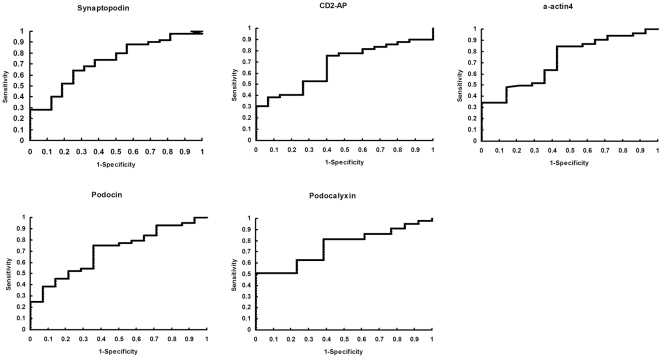
ROC-curve analysis of mRNA levels.Fraction of true positive results (sensitivity) and false positive results (1-specificity) for mRNA levels of synaptopodin, CD2-AP, α-actin4, podocin, and podocalyxin as predictors of DN. The calculated area under the curve was 0.726 for synaptopodin mRNA levels (95% confidence interval 0.589 to 0.864), 0.671 for CD2-AP mRNA levels (95% confidence interval 0.53 to 0.811), 0.725 for α-actin4 mRNA levels (95% confidence interval 0.582 to 0.867), 0.753 for podocalyxin mRNA levels (95% confidence interval 0.623 to 0.883), and 0.706 for podocin mRNA levels (95% confidence interval 0.559 to 0.853). A value of 0.5 is no better than that expected by chance (the null hypothesis), and a value of 1.0 reflects a perfect indicator.